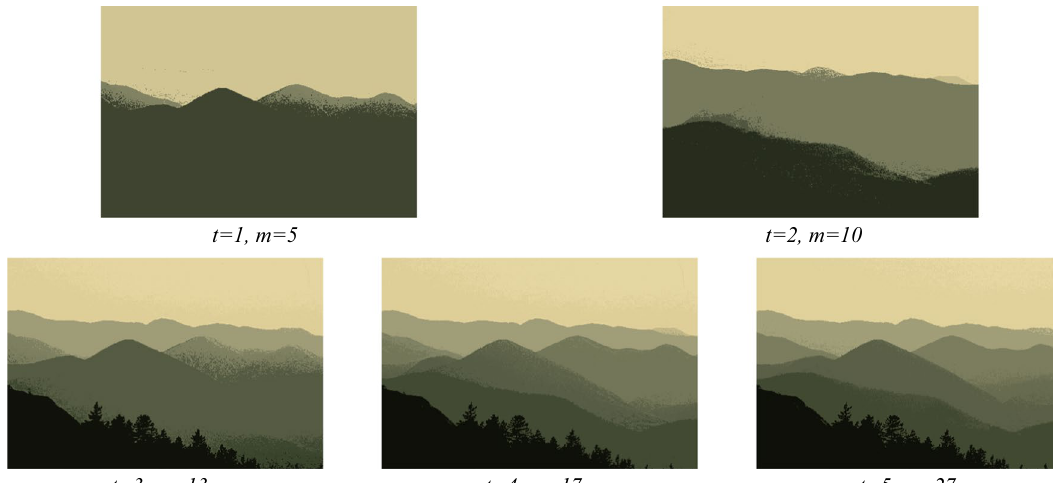
Fig. 15 Quantized 55067 image using